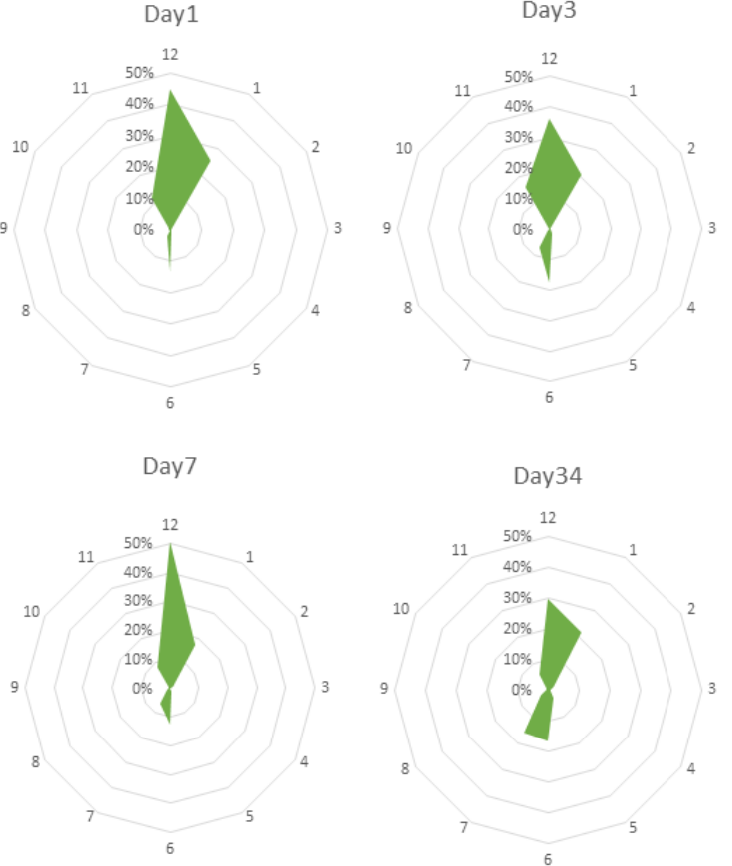
Figure 4. Sow orientation in Free pens on D1, D3, D7 and D34 (approximately day 25 of lactation) after entry. Position 12 represents the feed trough, and position 6 the rear wall of the pen. An increasing distance between the data point representing each position from the centre point of each graph indicates an increasing proportion of observations with the head oriented towards this position. The shaded area represents the proportion of observations for which sows were oriented in each direction.